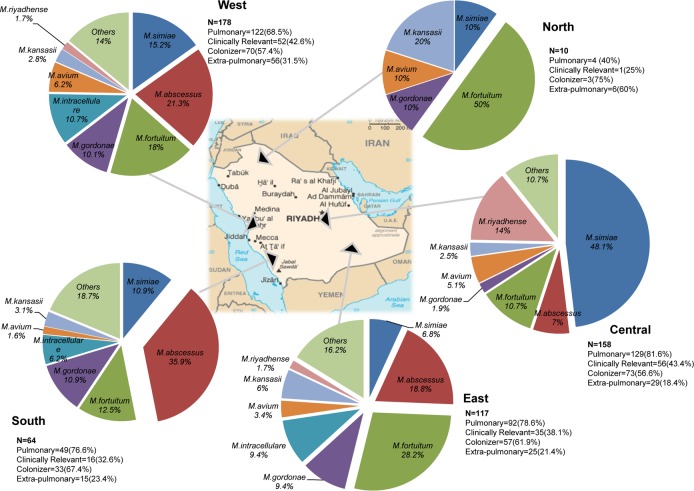
Geographical distribution and clinical relevance of major NTM species in Saudi Arabian provinces.This figure explains the distribution of the major NTM species in different geographical regions of Saudi Arabia. The used map of Saudi Arabia has been adapted from the open map resource https://commons.wikimedia.org/wiki/Atlas_of_Saudi_Arabia. ,.. Pie charts created and embedded by using MS Office Excel and Adobe Photoshop.